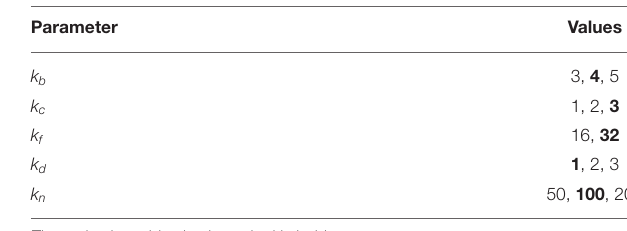
The optimal combination is marked in bold.